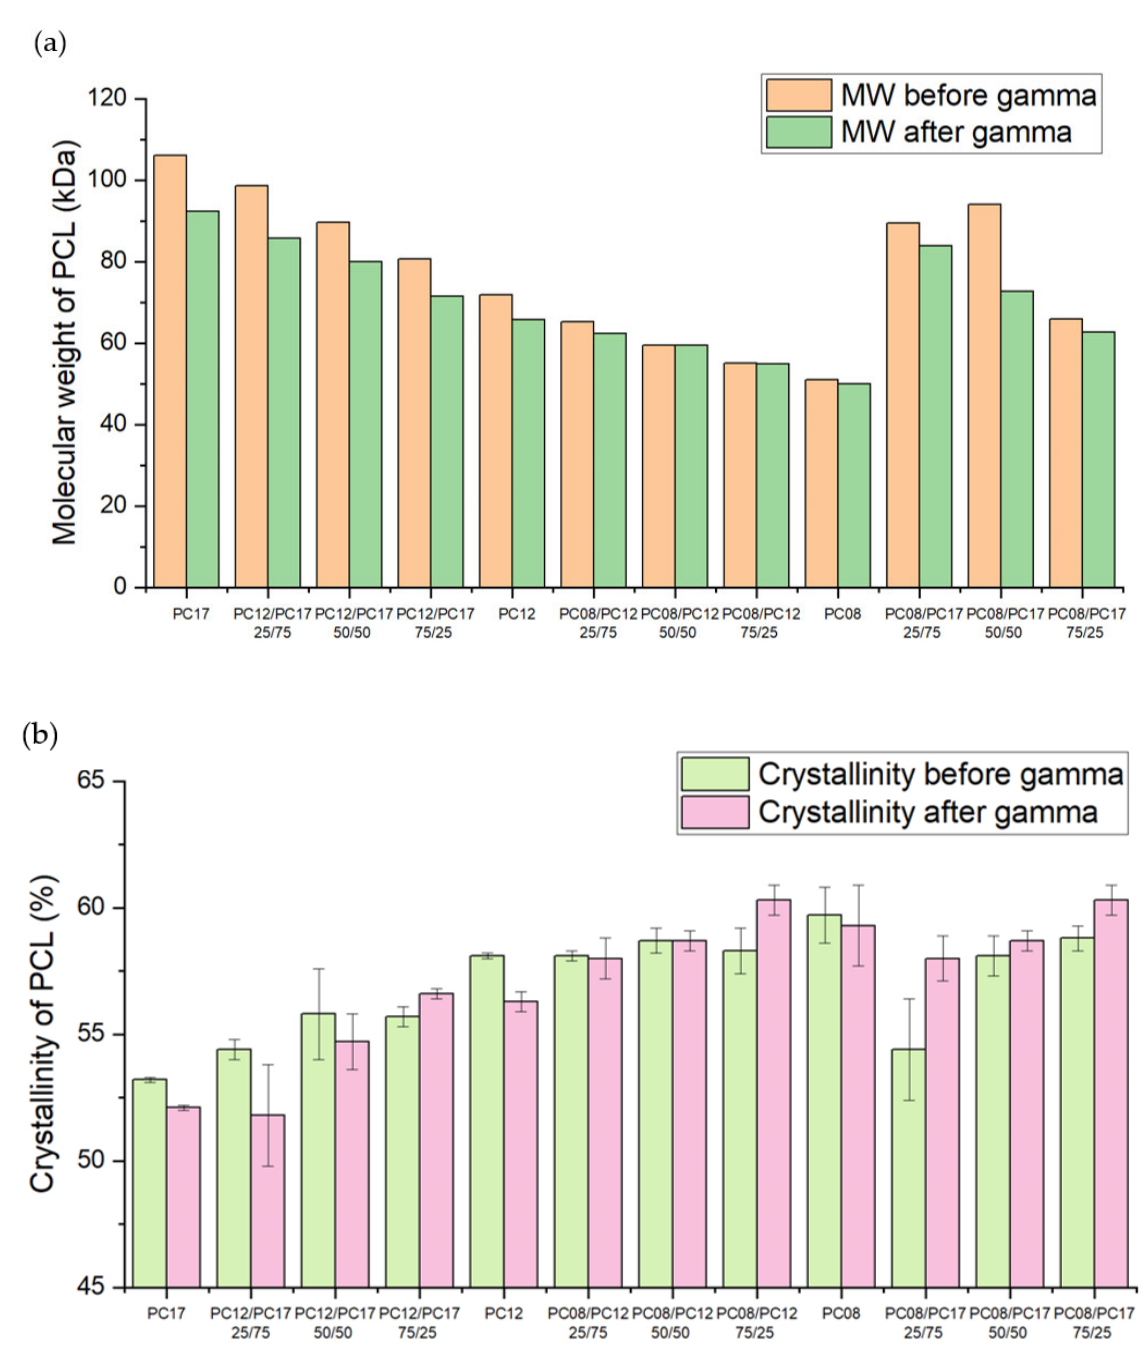
Figure 5. ( a ) The weight average MW and ( b ) the crystallinity of the extruded tubes comprising PCL binary blends after gamma irradiation. The extruded tubes had a wall thickness of 100 µ m and an OD of 2.5 mm. The % crystallinity reflects the mean values ± standard deviation of three independent measurements, whereas the MW value was reported based on one measurement.